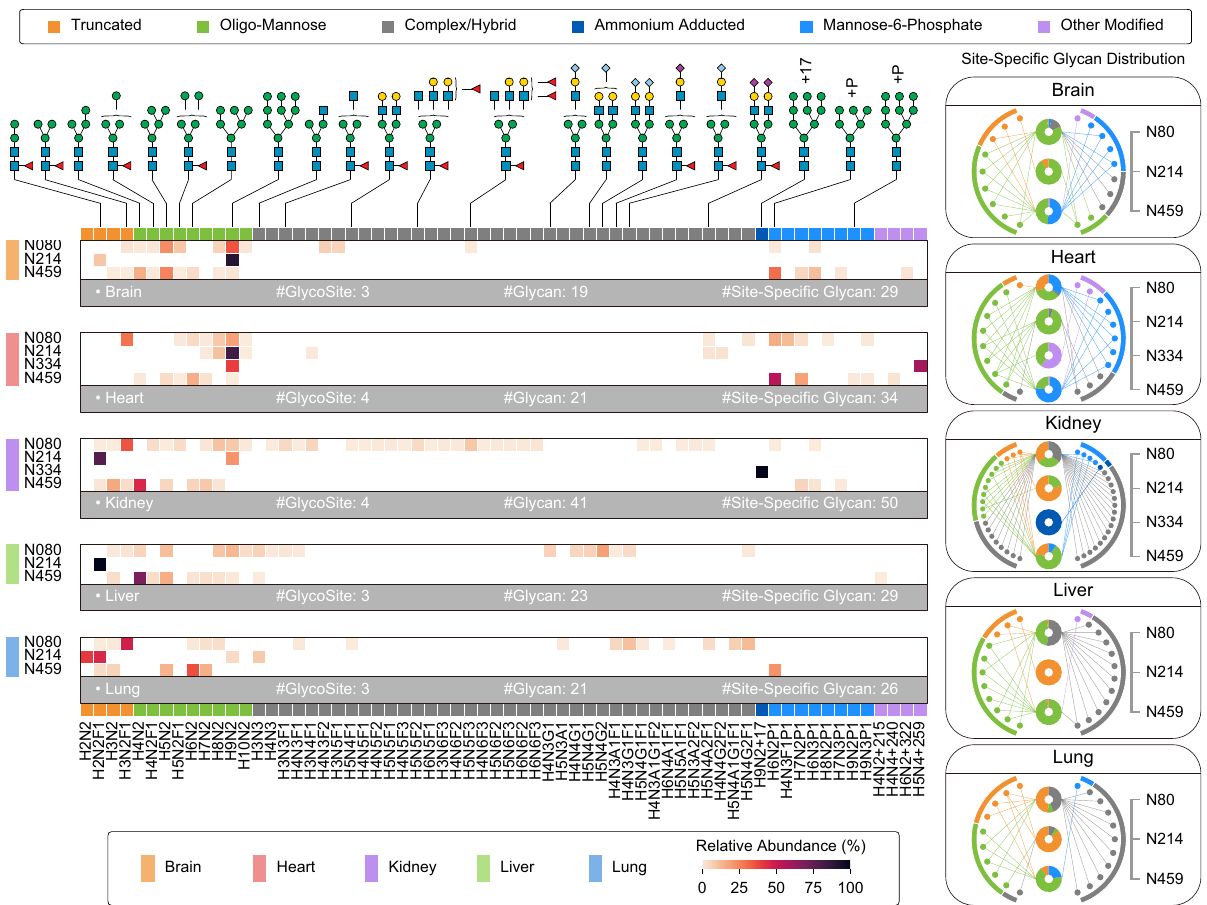
Fig. 5 Quantitative analysis of site-speci fi c glycosylation on prosaposin by Glyco-Decipher. Relative abundance distribution of glycans at each glycosite in prosaposin across fi ve mouse tissues (heat map). Compositions and possible structure illustration of the high-abundance glycans are annotated at the top. For a more intuitive demonstration, the abundance distributions of glycans at each glycosite are listed in the right radial diagrams. In each radial diagram, nodes around the circle denote glycans linked to prosaposin, and donuts in the center denote glycosites identi fi ed in prosaposin. Linkage between the node and the center donut indicates that the glycosite was modi fi ed by the corresponding glycan. The percentage value in each donut indicates the relative abundance for a certain type of glycan. All M6P identi fi cations were validated by the diagnostic oxonium ion (phosphorylated hexose, m/z = 243.0269) in glycopeptide spectra. H Hex, N HexNAc, A NeuAc, G NeuGc, F Fuc, P Phosphorylation. See Supplementary Data 7 for detailed information of glycan